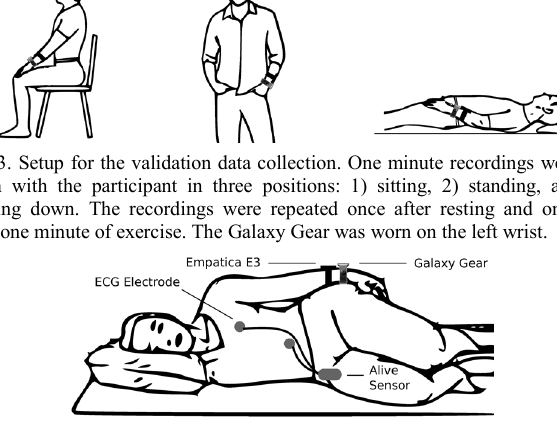
Fig. 4. Setup for the data collection during the sleep experiment. ECG electrodes were attached to the skin near the heart and on the abdomen. The Galaxy Gear was worn on the left